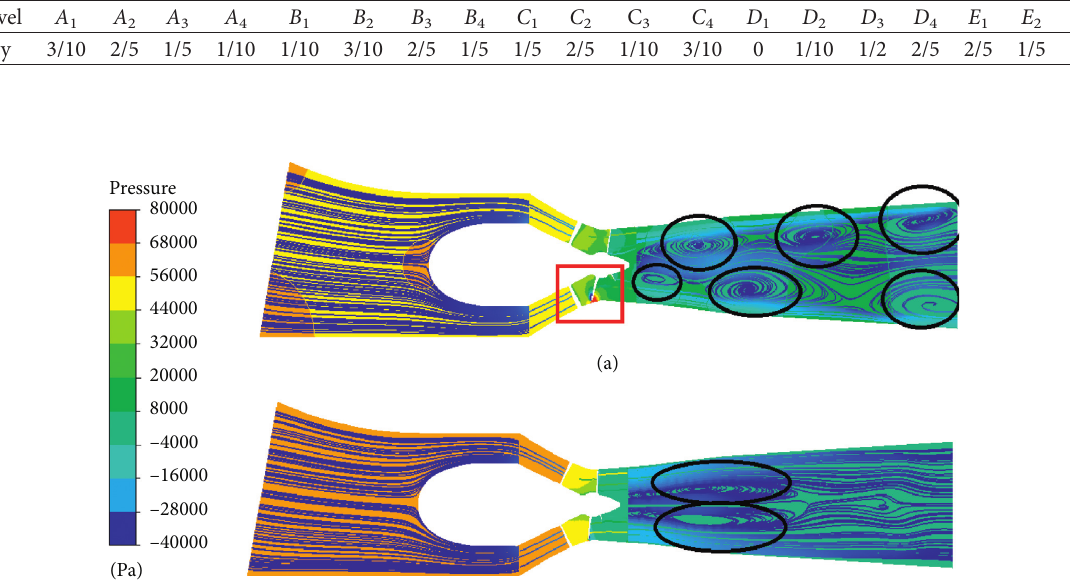
Figure 12: Streamline pressure diagram of X � 0 cross-section full flow channel before and after optimization: (a) before optimization; (b) optimized.